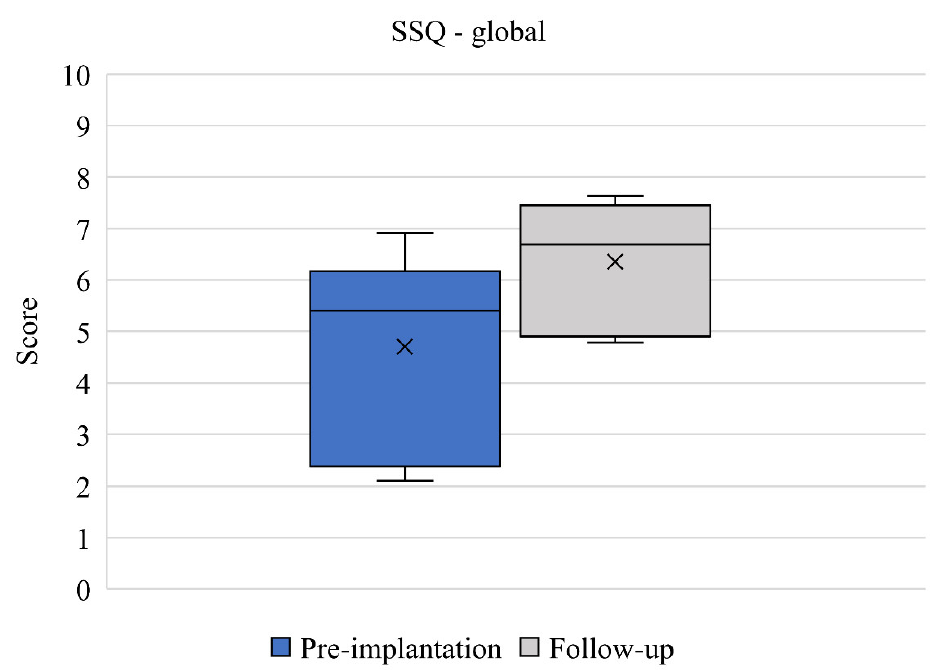
Figure 6. Global SSQ scores pre-implantation and at 12-month follow-up ( n = 6). Median values are represented by lines and means by crosses.